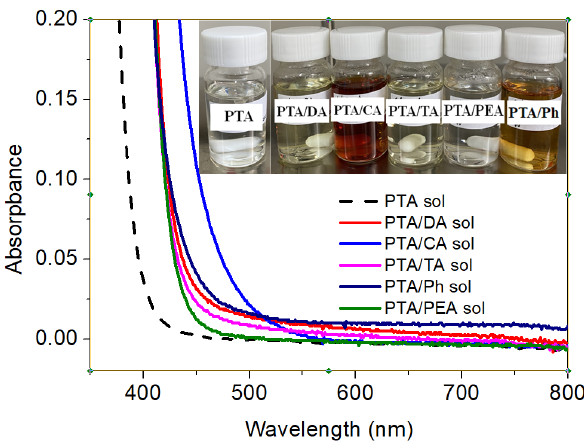
Figure 2. UV-Vis absorption spectra of the PTA, PTA/DA, PTA/CA, PTA/TA, PTA/Ph, and PTA/PEA sols. The inset showing the photos of these sols.